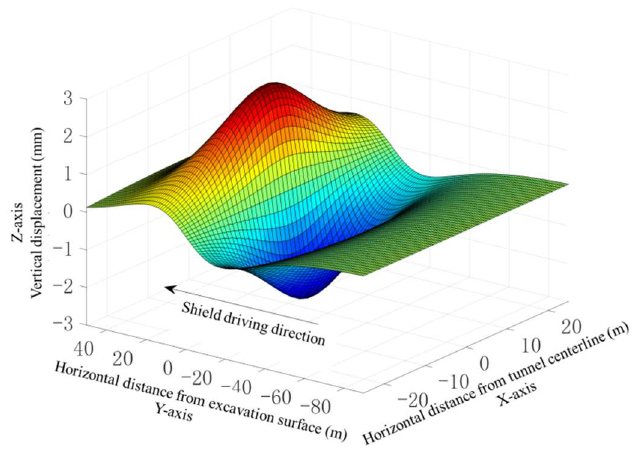
Figure 11. Ground movements induced by shield shell friction.